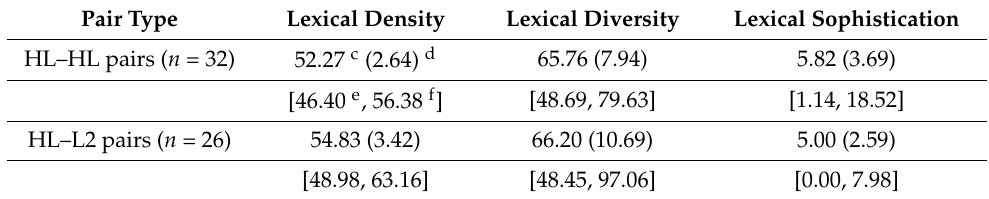
Table 2. Descriptive statistics for lexical density, lexical diversity and lexical sophistication